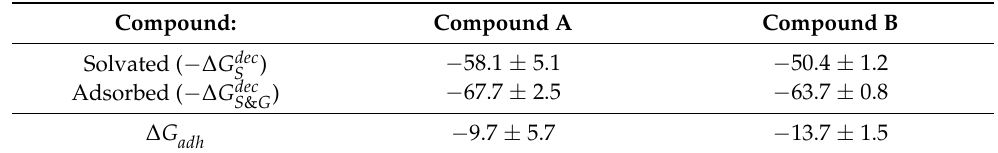
Table 2. Average Gibbs free energies of solvation and adhesion of bis-(Zn)salphen dimers in DCM (kcal/mol). Confidence interval at 95% level for 5 independent